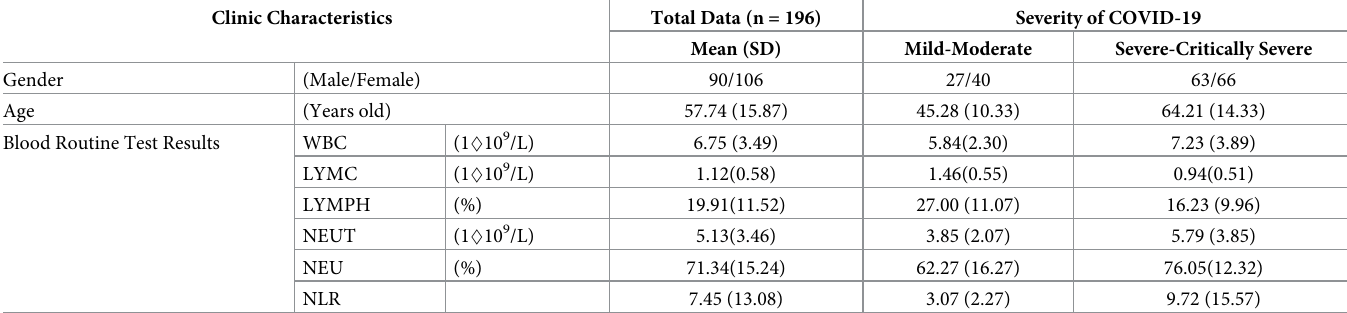
Table 1. Clinical features of COVID-19